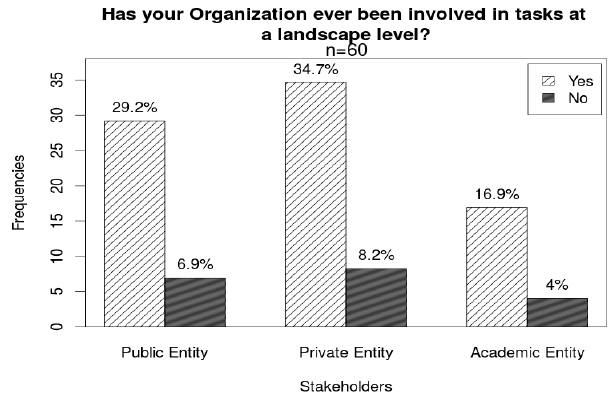
Figure 4. Frequencies of answers to the question “Has your Organization ever been involved in tasks at a landscape level (management, planning, recording or protection)?” by stakeholder type.